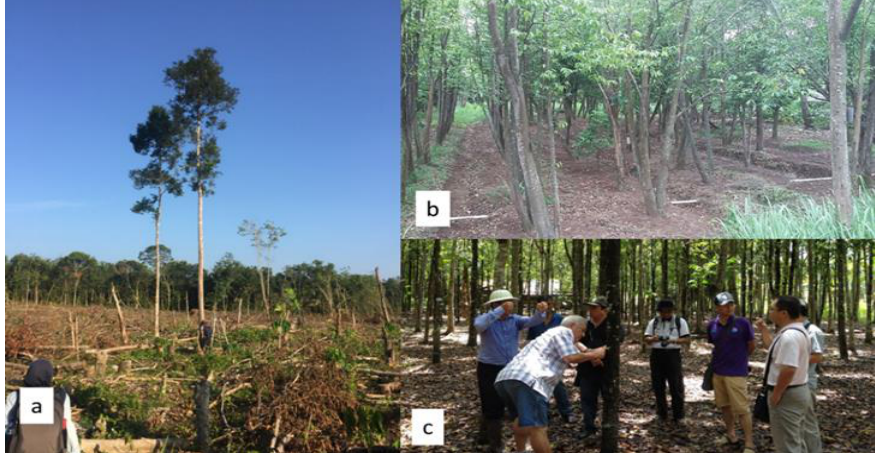
Figure 5. The population of natural agarwood producing trees has decreased, and they have been substituted by agarwood plantations in Indonesia: ( a ) Natural Aquilaria malaccensis in South Su- matera; ( b ) Aquilaria malaccensis plantation in Banten Province; and ( c ) Aquilaria microcarpa planta- tion in West Kalimantan.